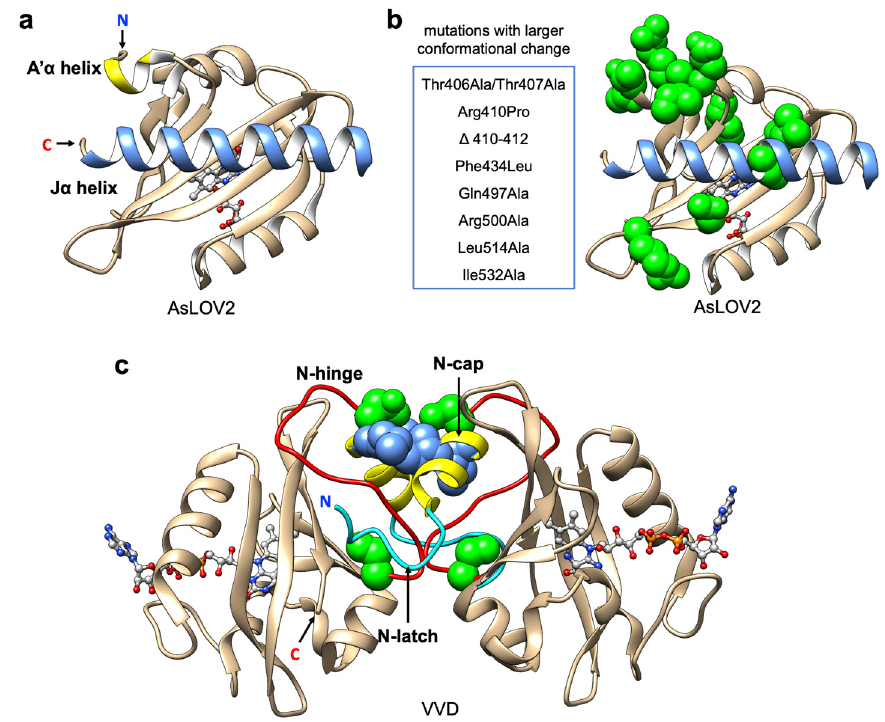
Figure 3. LOV domain structure and protein engineering. ( a ) Representative structure of AsLOV2 domain (PDB ID: 2V1B). J α -helix is represented in blue; A’ α helix is represented in yellow; flavin cofactor (FMN) chromophore is represented with light grey ball and stick; ( b ) Mutations that increase conformational change in AsLOV2 domain. Mutations listed are represented with green spheres. ( c ) Light-state dimer of Vivid (VVD) domains (PDB ID: 3RH8). N-Cap helixes are represented in yellow; N-hinge loops are represented in red; N-latch peptides are represented in cyan; FAD chromophores are represented with light grey ball and stick; mutations (Cys71Val and Asn56Lys) that increase the dimer affinity are represented with green spheres; mutations (Ile52Arg and Met55Arg in pMag; Ile52Asp and Met55Gly in nMag) that used in Magnet system are represented with blue spheres.